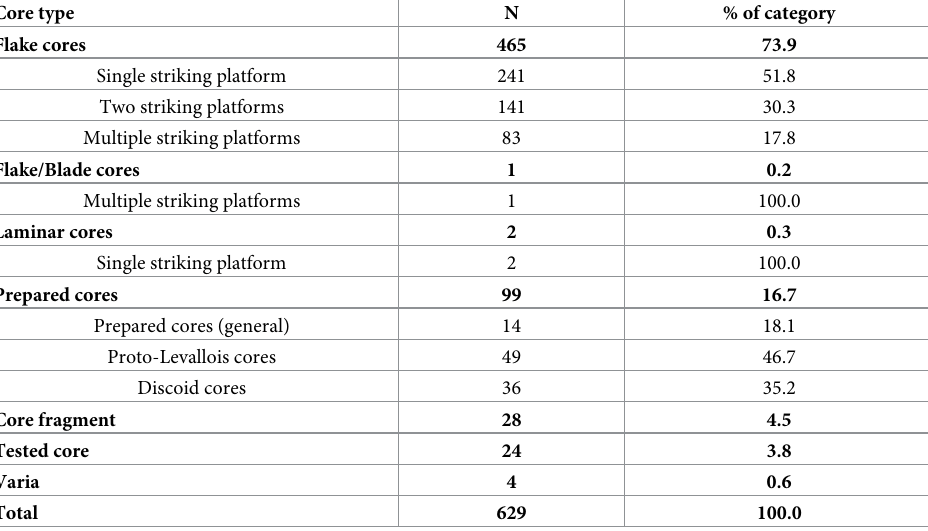
Table 8. Techno-typological distribution of the cores in the assemblage (excluding cores on